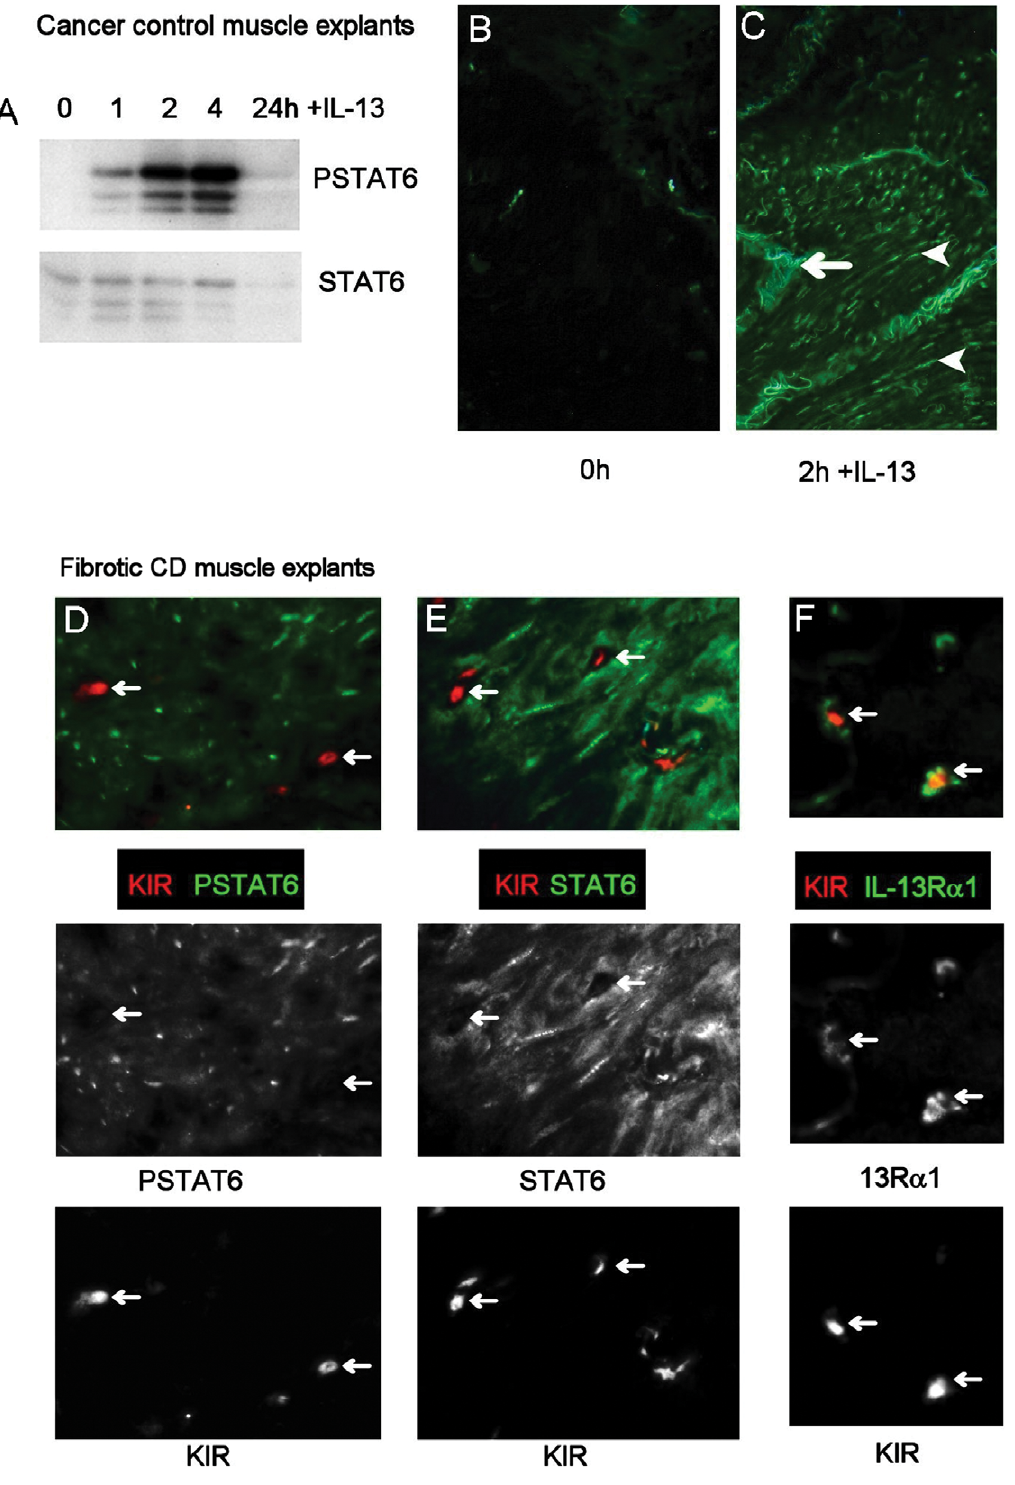
Figure 8. IL-13 activates smooth muscle cells, but not KIR + cells, in tissue explants. Tissue explants were cultured with or without IL-13 for 1–24 h. Explants were then snap frozen and processed for Western blotting or immunoflorescence. (A–C) IL-13 signaling in explanted intestinal muscle tissue. (A) Time course for activation of STAT6 by Western blotting or (BC) by immunofluorescence in cancer control tissue. Arrowheads indicate positive nuclei, arrow indicates autoflorescence. (D–F) Double labeling for KIR and PSTAT6 (Panel D), STAT6 (Panel E), or R a 1 (Panel F) in fibrotic CD explanted tissue after 2 h incubation with IL-13. Arrows show KIR + cells which colocalise with IL-13R a 1 but not with PSTAT6 or STAT6. A and C, 6 64, B, 6 20.